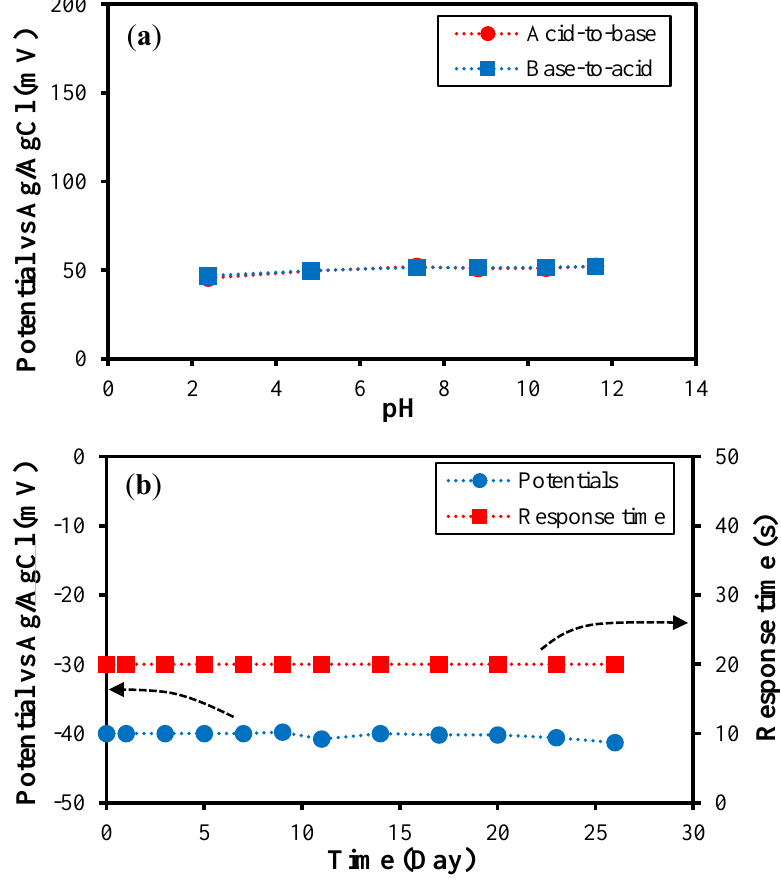
Figure 6. Effect of pH on the SSRE and the long-term stability of the SSRE. ( a ) Stability of the SSRE at pH levels ranging from 2.38 to 11.61 in the acid-to-base direction and vice versa . The potentials were measured using the ORE as the reference electrode; ( b ) Potentials and response times of the SSRE were measured in a 3 M KCl solution at intervals of 2 or 3 days over 26